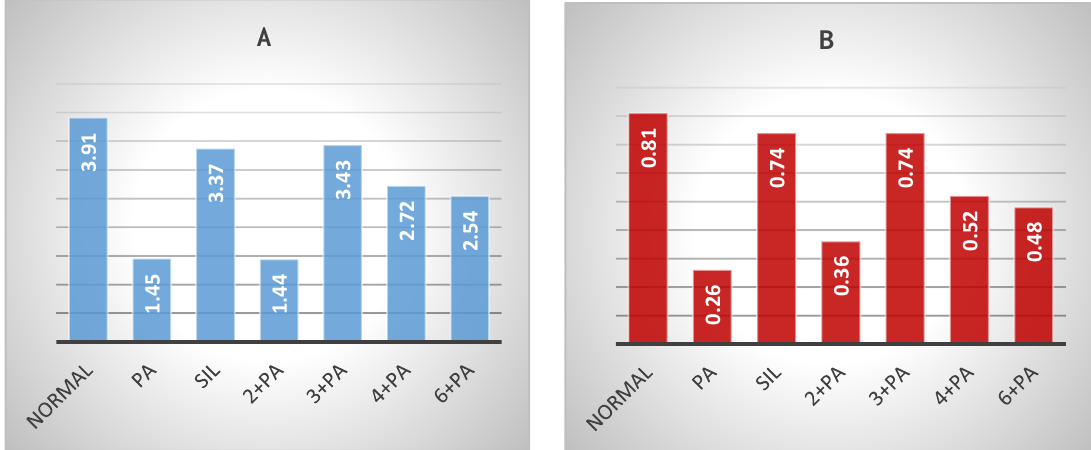
Figure 3. Effect of compounds 2 – 4 , 6 on liver ( A ) and kidney ( B ) TP.